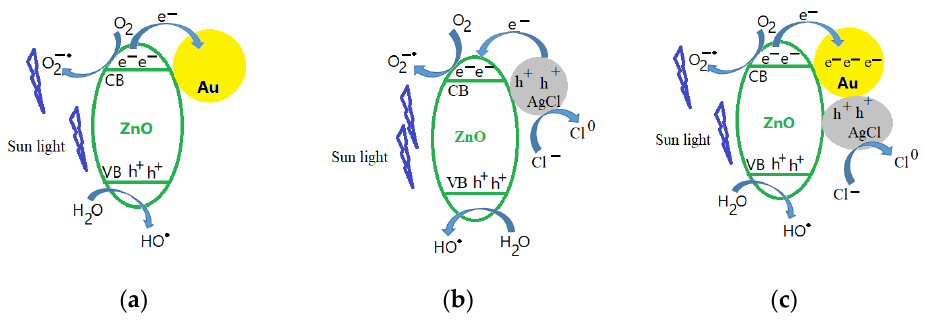
Figure 9. Schematic representation of the RhB degradation in the presence of the composite ( a ) AuZnO, ( b ) AgClZnO, and ( c )